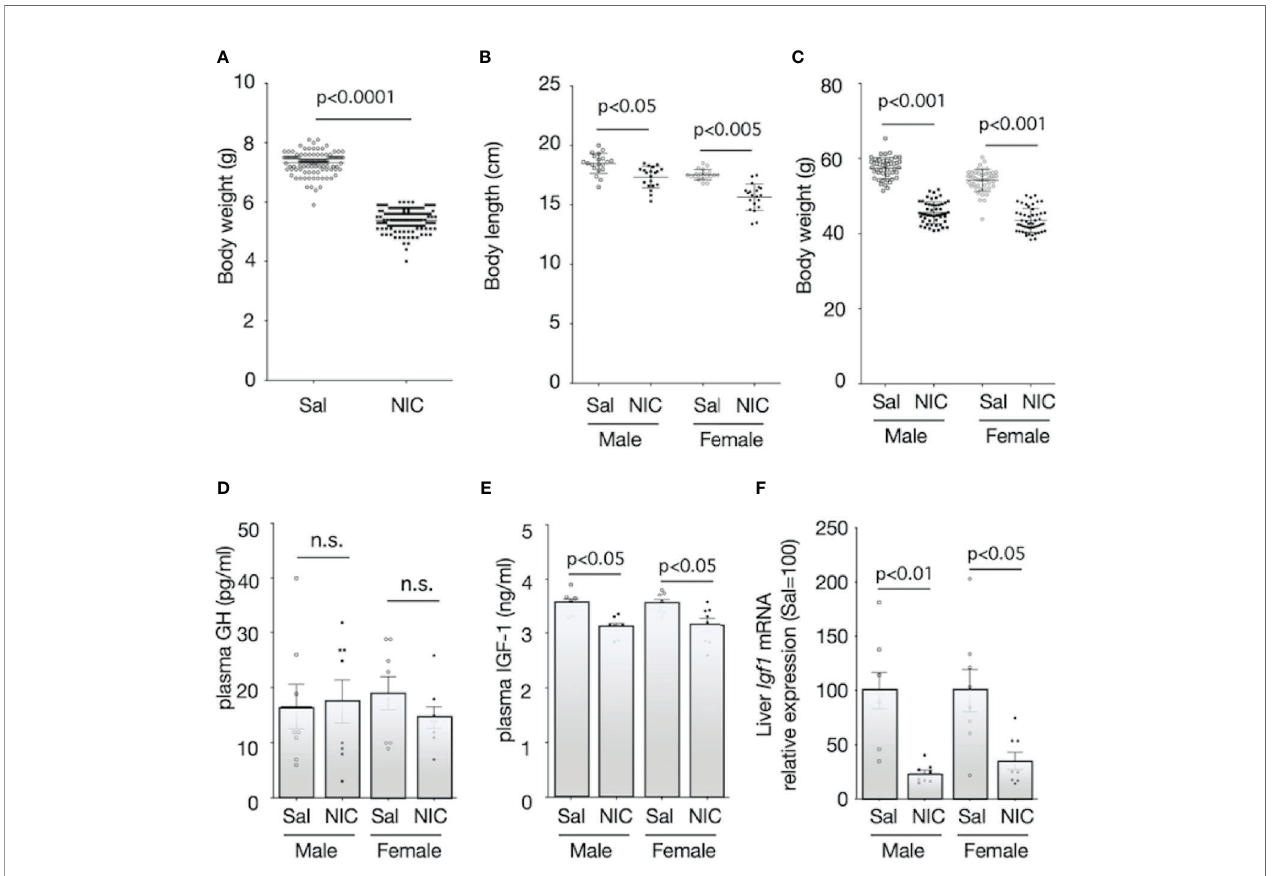
FIGURE 1 | Body size and plasma concentrations of GH and IGF-1, and expression of IGF-1 mRNA in the liver. Bodyweight at birthday (A) , body length (B) and bodyweight at weaning day (3-week-old) (C) were measured. Plasma concentrations of growth hormone (GH) (D) and insulin-like growth factor (IGF)-1 (E) of offspring from nicotine-administered dams (NIC) and saline-treated dams (Sal) were measured. The mRNA expression levels of Igf1 in the liver of offspring from nicotine-administered dams (NIC) and saline-treated dams (Sal) were quanti fi ed (F) . The mRNA expression levels were normalized to Gapdh levels and then to that in Sal, which was de fi ned as 100%. Values are presented as means ± SEM (n=8). Statistical analysis was performed using unpaired-T test (A) and one-way ANOVA followed by Tukey ’ s post hoc test for multiple comparisons (B – F) . n.s., not signi fi cant (p ≥